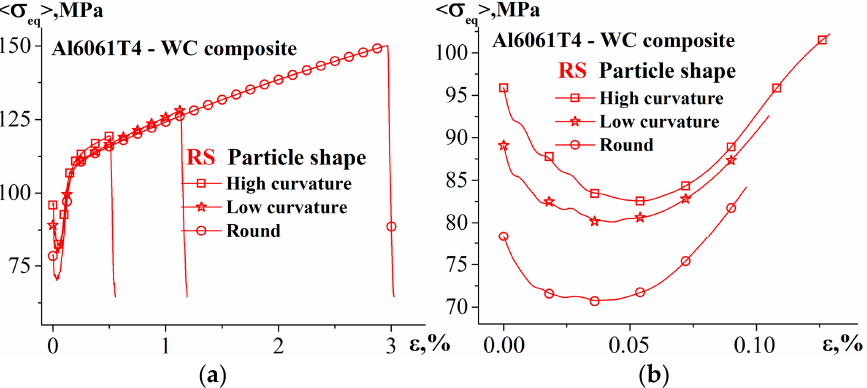
Figure 15. Patterns of equivalent plastic strain in the Al6061T4 matrix and fractured regions in the WC particle for the round ( a ), low-curvature ( b ) or high-curvature ( c ) particles.